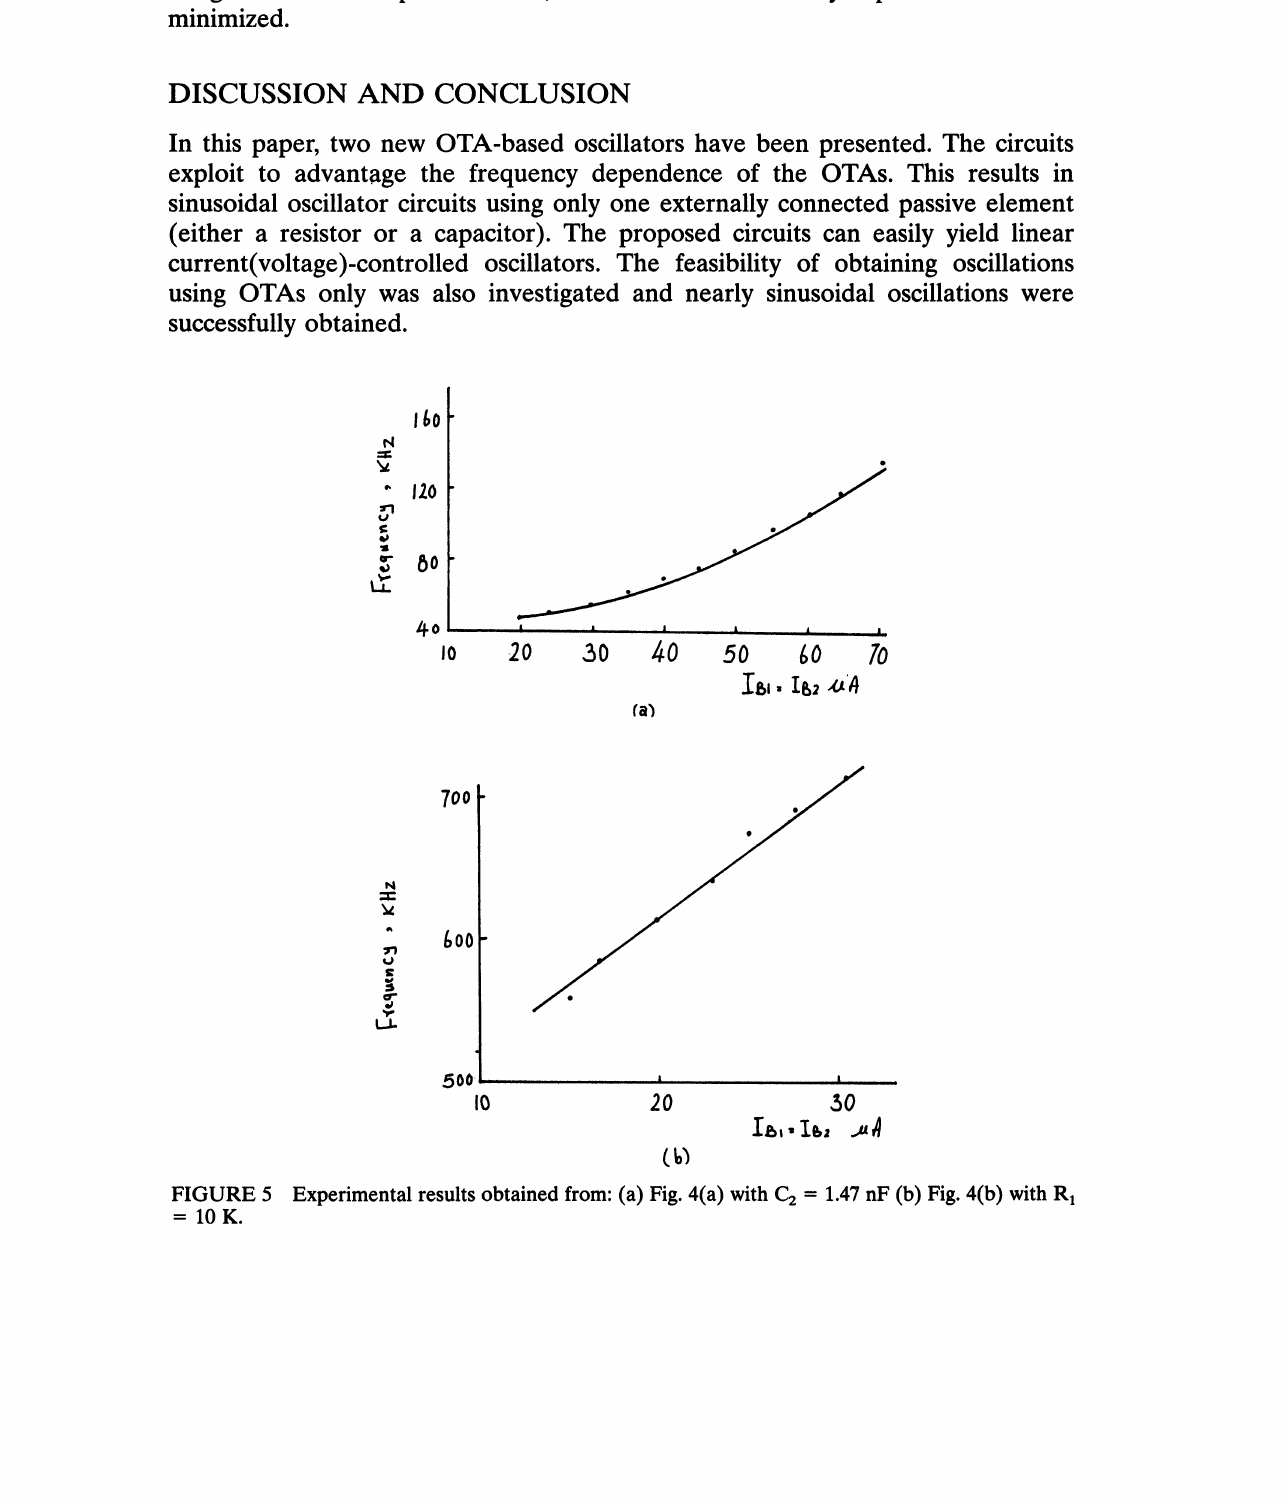
FIGURE 5 Experimental results obtained from: (a) Fig. 4(a) with C2 1.47 nF (b) Fig. 4(b) with R